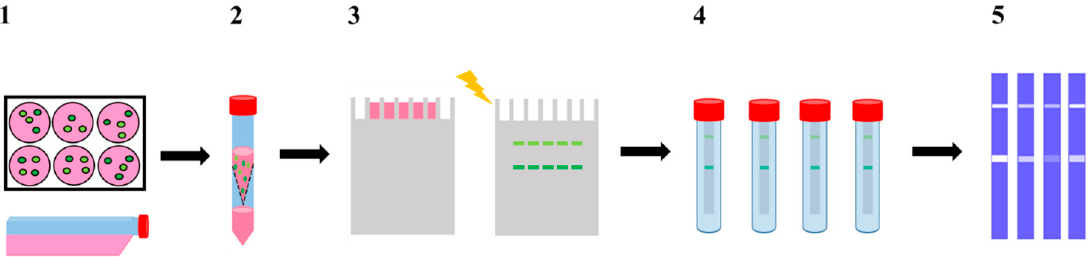
Figure 2. Schematic representation of the modified gelatine zymography assay. ( 1 ) 2D (CM2D) and 3D (CM3D) cultures conditioning in serum free media for 24 h; ( 2 ) CM2D / 3D collection and concentration (100 × ); ( 3 ) CM2D / 3D analyzed by SDS-PAGE containing 0.1% gelatine as substrate; ( 4 ) developing bu ff er incubation step of individual lanes with [15]pyN 5 , [16]pyN 5 and ARP-100; ( 5 ) staining with Coomassie Brilliant Blue solution.